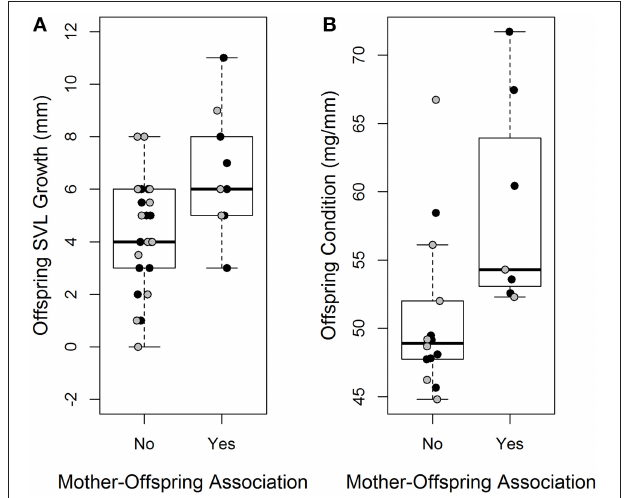
FIGURE 2 | Difference in offspring svl growth (mm) (A) and offspring body condition (mg/mm) (B) between offspring who associated with their mother and those who did not. Black data points indicate offspring from the clumped treatment, gray data points indicate offspring from the dispersed